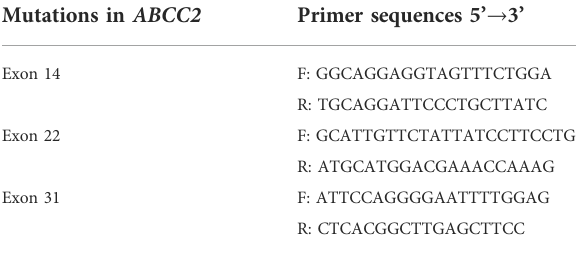
TABLE A1 Primer sequences used for mutation sequencing of ABCC2 gene. Mutations in ABCC2